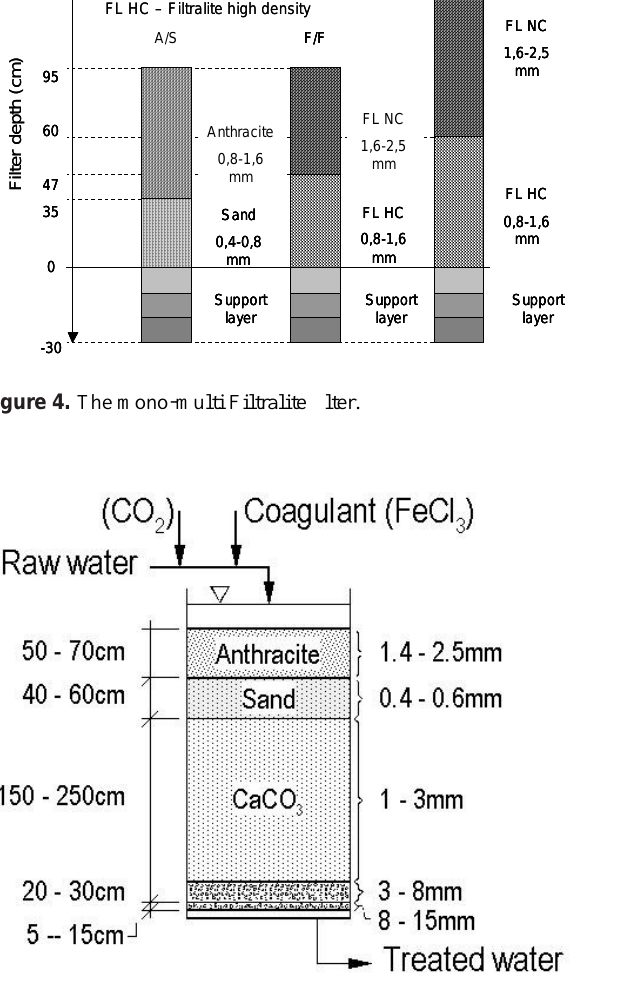
Figure 5. The three media filter for coagulation / carbonatisation.